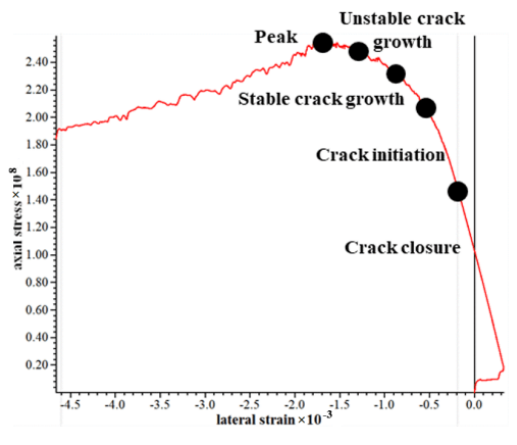
Figure 18. Stress – strain curve at 20 × 10 6 confining pressure. ( a ) horizontal stress-strain curve, ( b ) vertical stress-strain. Table 3. Calculation results of compressive strength of biaxial test.